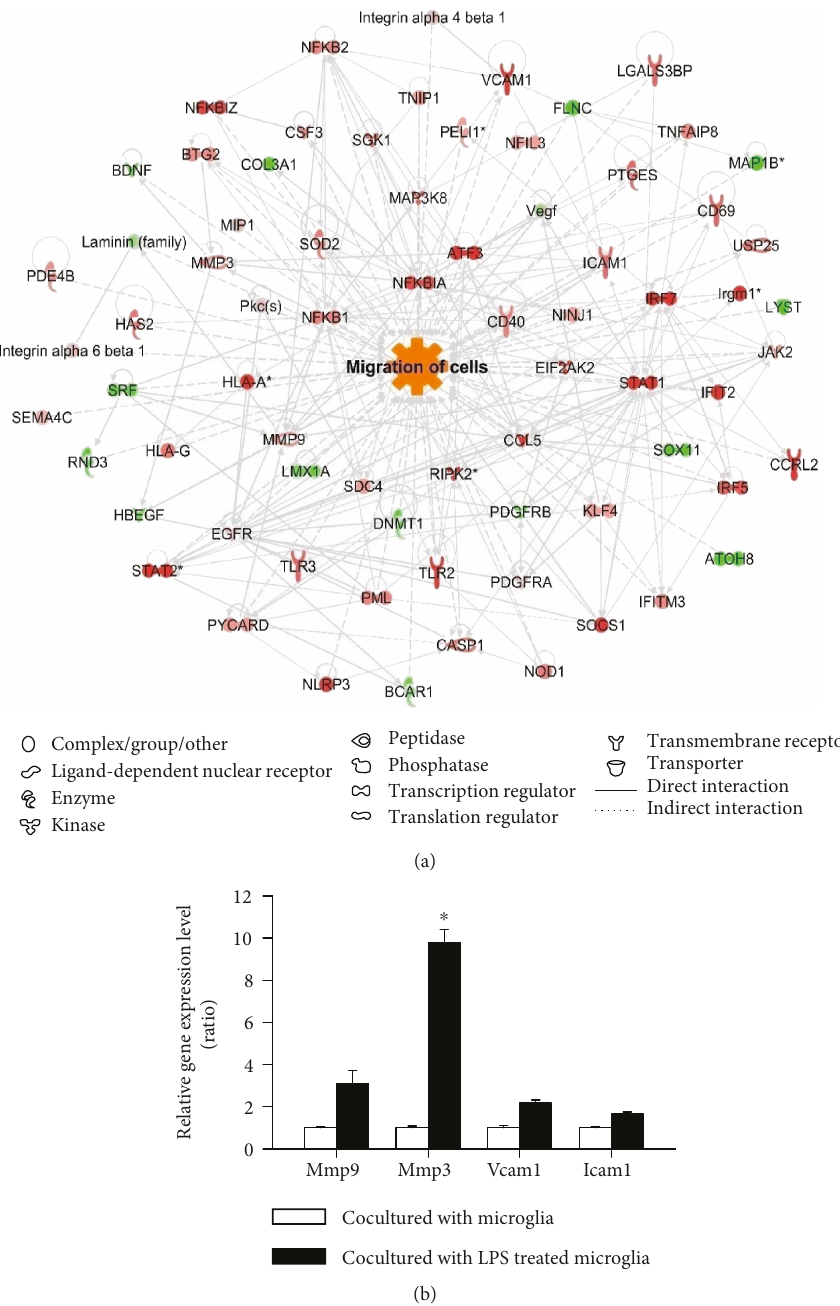
Figure 2: Increase in migration of rat bone marrow-derived mesenchymal stem cells (rBM-MSCs) cocultured with LPS-stimulated microglia. (a) Gene network related to cell migration was constructed, and cellular function was predicted algorithmically using Ingenuity Pathway Analysis. Red and green areas indicate up- and downregulated genes, respectively. Di ff erentially expressed genes were obtained from microarray data ( > 1.2 fold change). (b) quantitative RT-PCR analysis of gene expression related to cell migration in rBM-MSCs cocultured with LPS-stimulated microglia compared to rBM-MSCs cocultured with microglia. Data represent the mean of three independent experiments. ( mean ± SD ) ∗ p < 0 05 versus rBM-MSCs cocultured with